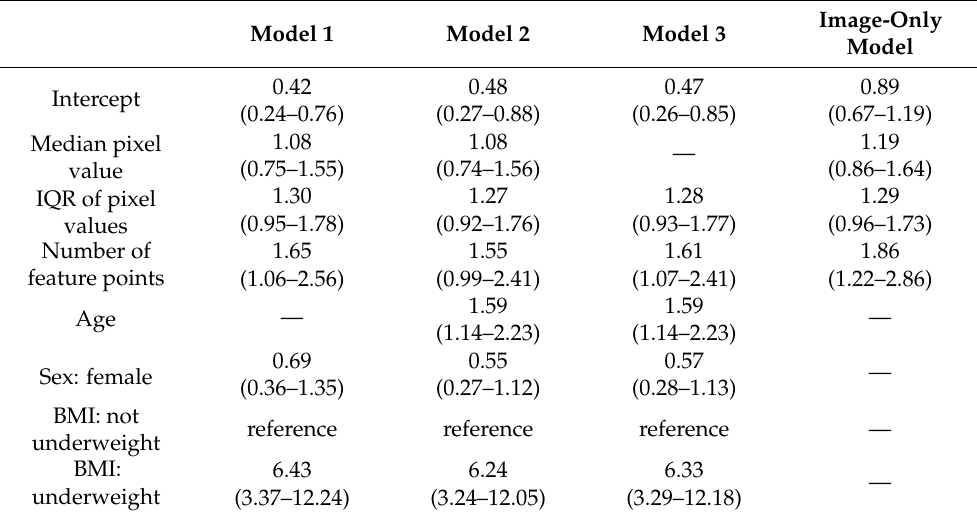
Figure 3. Gray scale images and relative feature points detected by the Features from Accelerated Segment Test (FAST) algorithm. Table 2. Estimated odds ratios of the tested models for sarcopenic dysphagia.